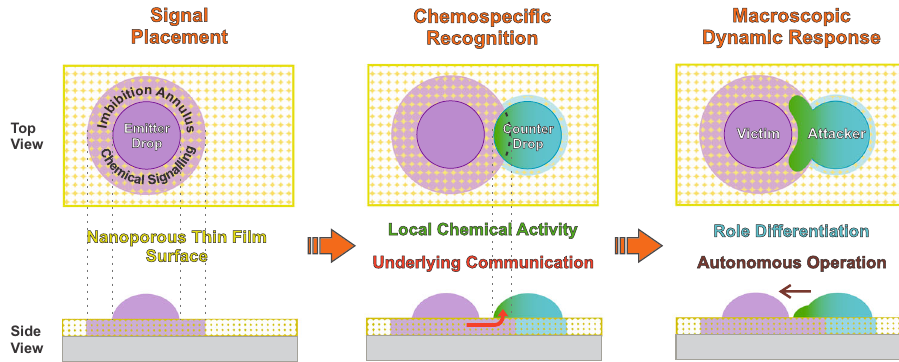
Fig. 1 Schematic concept of the underlying nanoporous layer mediation to achieve complex inter-droplet responses. When chemically complementary drops are deposited together onto a nanoporous thin fi lm, they interact and subsequently act by themselves via underlying chemical messages and localized activity, leading to a macroscopic response. These droplets can spontaneously evolve to a chemospeci fi c stimulus-response operation, which resembles an emergent “ intelligent ” behavior. The triggered autonomous attacker-victim-like non-reciprocal interactions lead to the generation of distinctive droplet dynamics with shape-transformation and complex behaviors. Note that the schemes are out of scale (e.g., the thickness of the nanoporous thin fi lm is about a few hundred nanometers, which is much smaller than the droplet height).